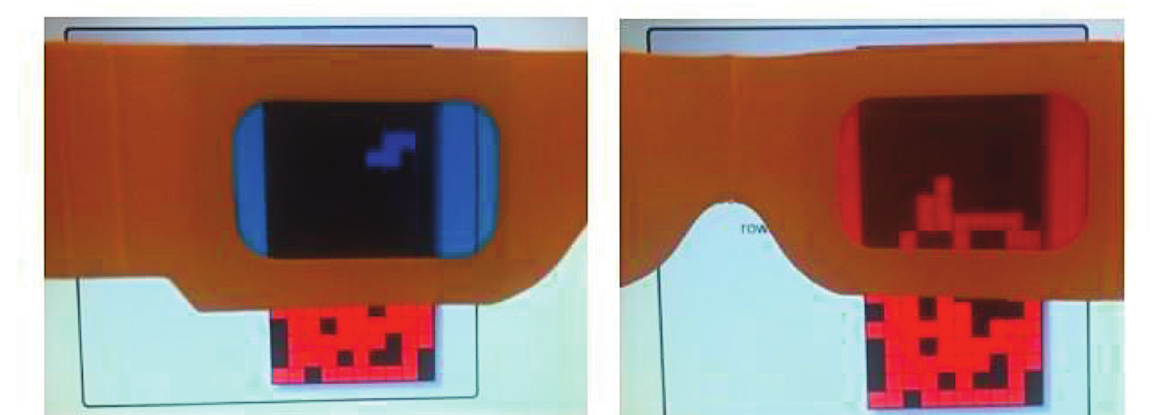
Fig. 2. Red­blue filters separate Tetris® game elements. For example, the amblyopic eye is the right eye. The blue falling blocks are seen by the non­amblyopic eye (the left eye) in low contrast conditions, while red base blocks are seen by the amblyopic eye (the right eye) in high contrast